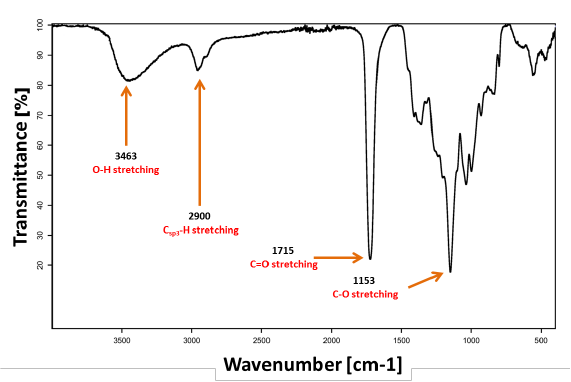
Figure 2. Fourier transform infrared spectroscopy (FTIR) spectra of PGSu.